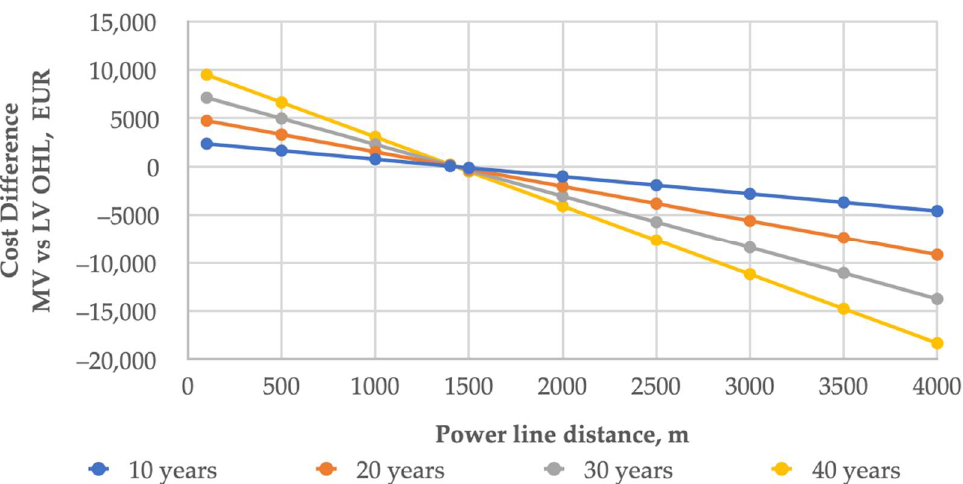
Figure 1. Difference between the total costs of the MV OHL and the LV OHL (positive cost if LV OHL is more feasible, and negative cost if MV OHL is more feasible).